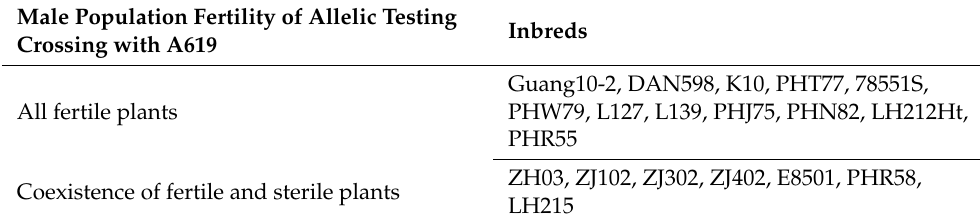
Table 7. Summary of the allelic tests in the populations derived from the cross between the CHZS, A619, and tester